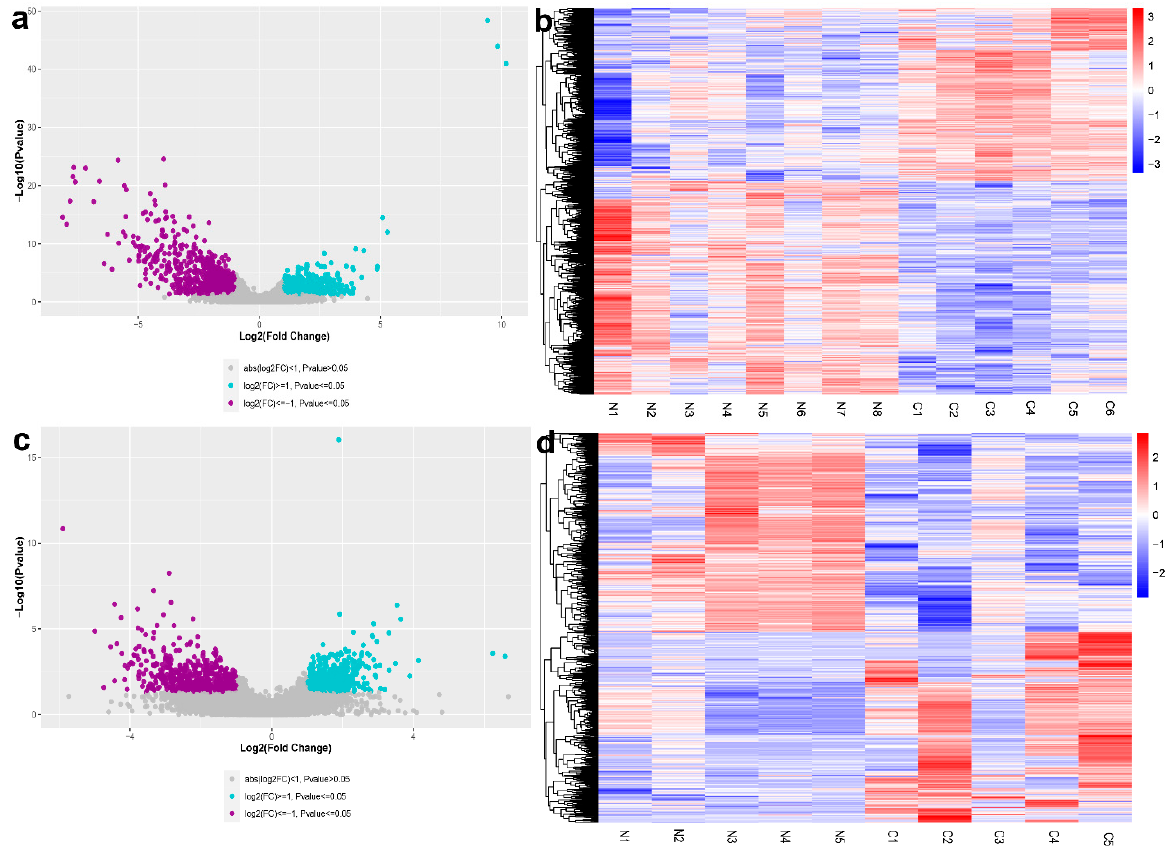
Figure 1. Differentially expressed genes (DEGs) in posterior subcapsular congenital cataract patients compared with in normal control samples. ( a ) Volcano plots of the DEGs in the anterior lens capsule samples. Blue dots indicate upregulated genes, and purple ones represent downregulated genes; ( b ) hierarchical clustering performed on the DEGs in the anterior lens capsule samples; highly expressed genes are shown in pink, and the lower ones are shown in blue; C indicates congenital cataract samples, while N represents normal control samples; ( c ) volcano plots of the DEGs in cortex and nuclear fibres; blue dots indicate upregulated genes, and purple dots represent downregulated genes; ( d ) hierarchical clustering performed on the DEGs in cortex and nuclear fibres.